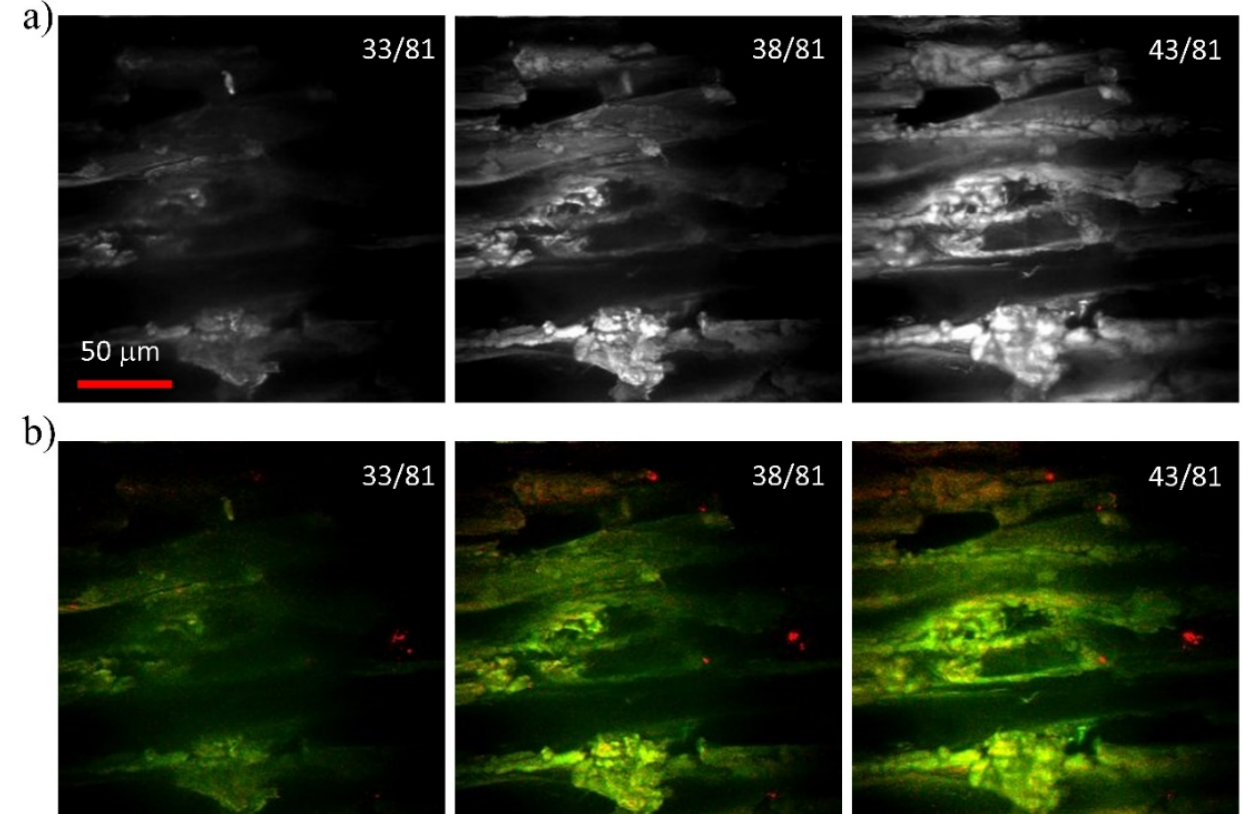
Figure 3. ( a ) Poplar greyscale NLO microscopy images (200 × 200 µ m 2 ) and ( b ) corresponding TPEF/SHG merged images acquired at different depths inside the wood slice (tangential section), highlighting the presence of SHG emitters. Depths of recording from the sample’s surface are indicated in the top right corner (81 µ m scanning depth; 1 µ m sampling